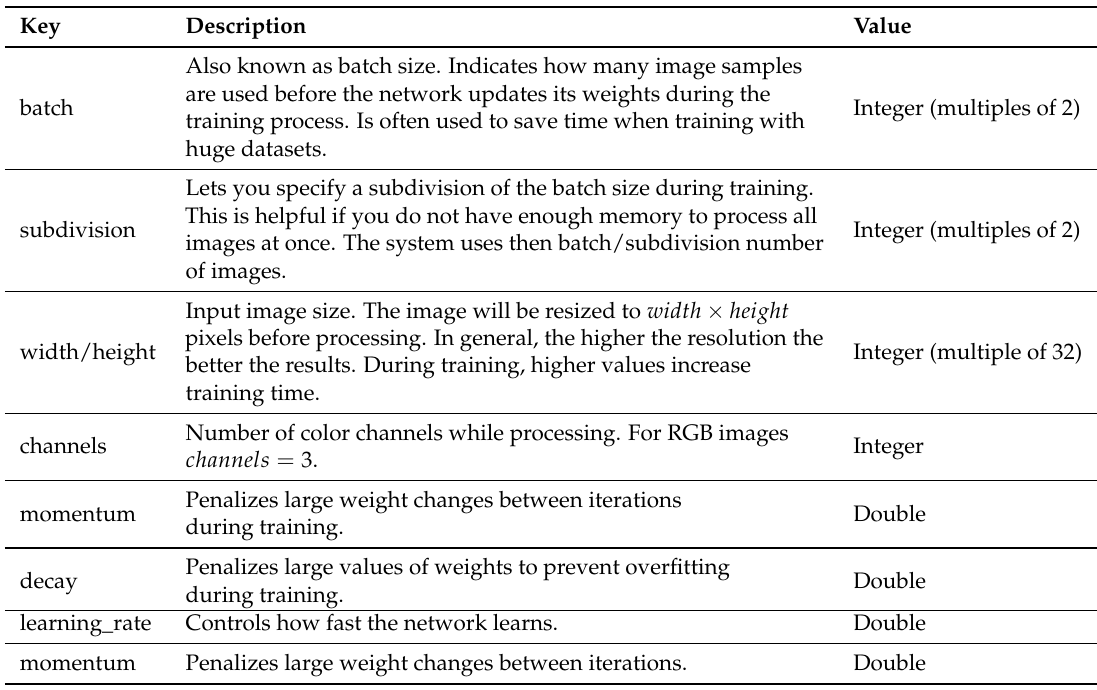
Table 2. Most important YOLOv3 configuration file entry